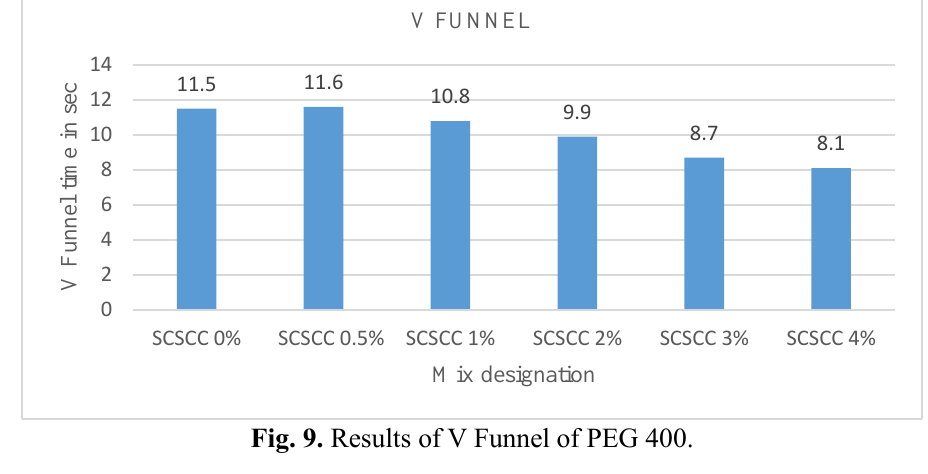
Fig. 8. Results of V Funnel of Nano Silica.